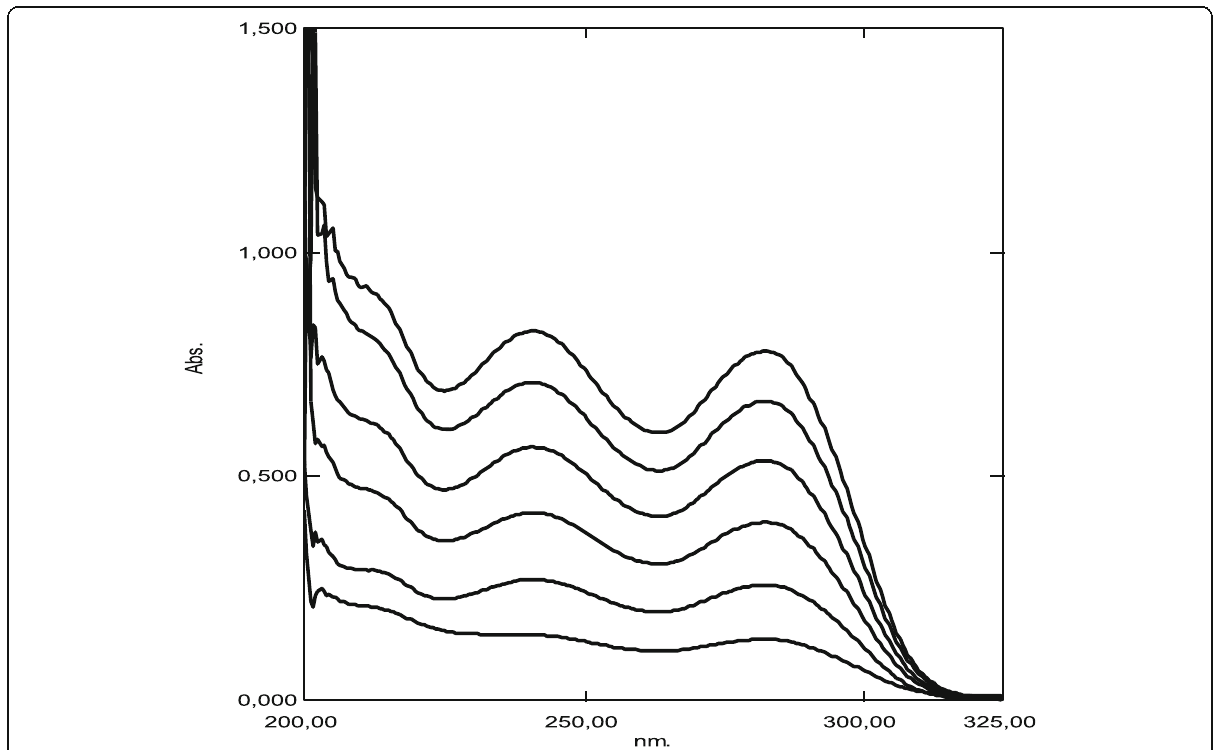
Fig. 10 Spectrums of the blank solution and the solutions containing increasing concentrations of